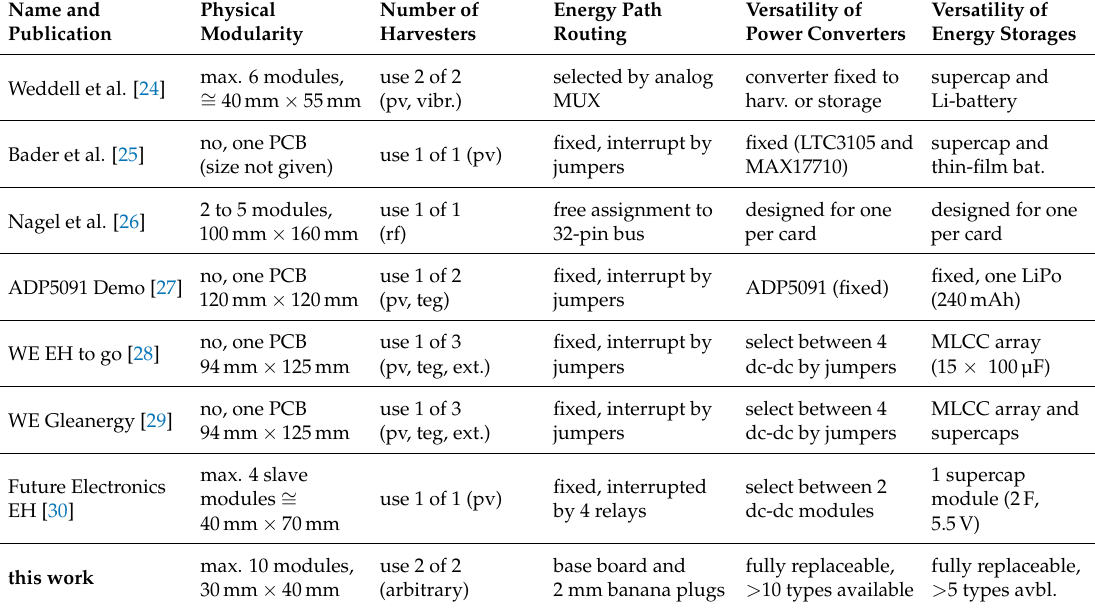
Table 5. Overview of evaluation systems for energy harvesting and micro-power